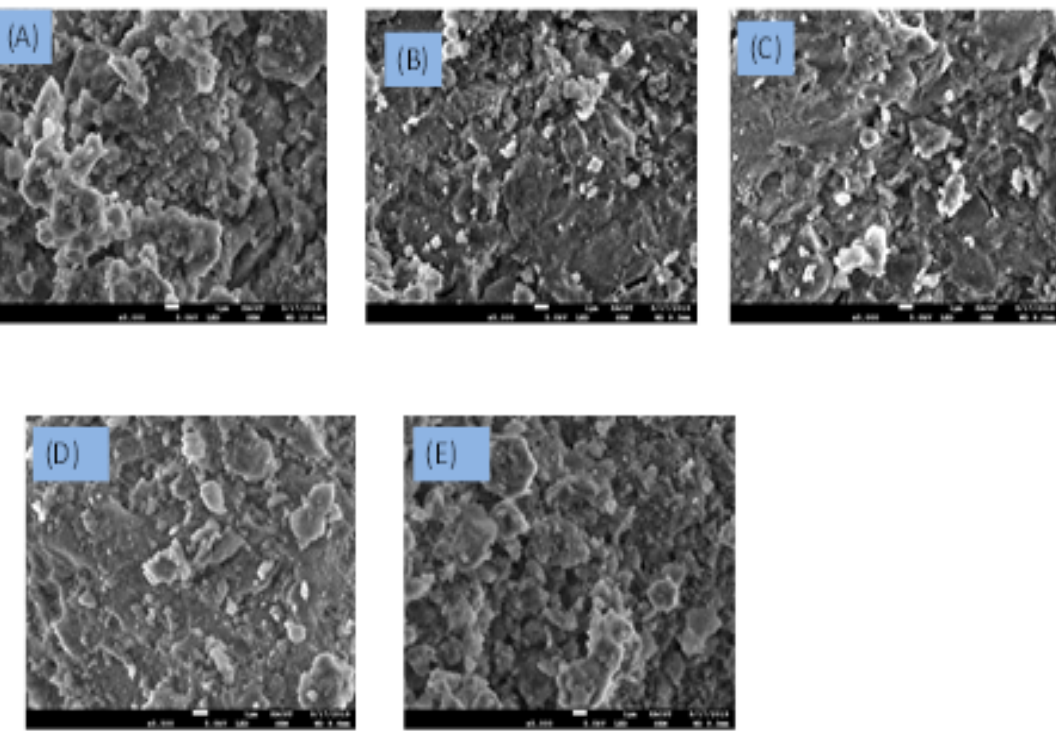
Figure 6. SEM images of the fresh catalysts ( A ) 5Ni / Al, ( B ) 5Ni + 1Gd / Al, ( C ) 5Ni + 1Zn / Al, ( D ) 5Ni + 1Cu / Al, and ( E ) 5Ni + 1Ga / Al.